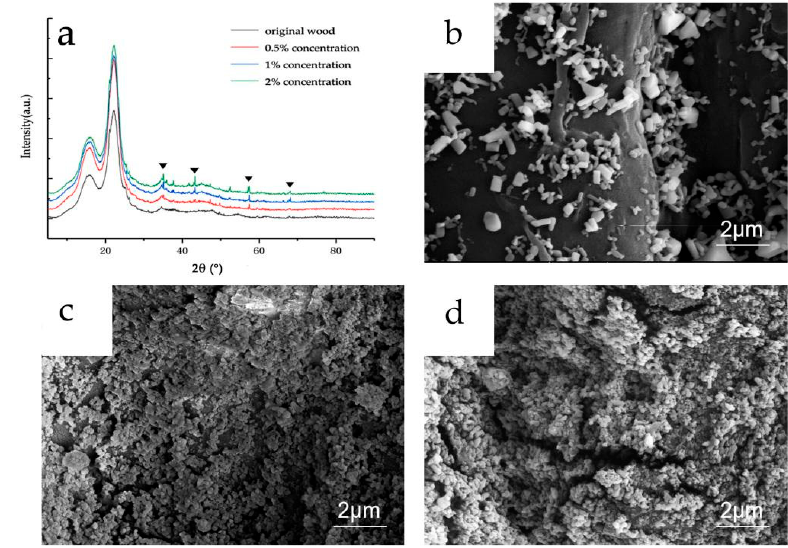
Figure 3. ( a ) X-ray diffraction (XRD) patterns of the original wood (black), concentrations of 0.5% (red), concentrations of 1% (blue), and concentrations of 2% (green); high-magnification SEM images of chitosan/sodium phytate/nano-Fe 3 O 4 composite coatings on wood surfaces obtained by different solution concentrations: ( b ) 0.5%, ( c ) 1%, and ( d ) 2%.